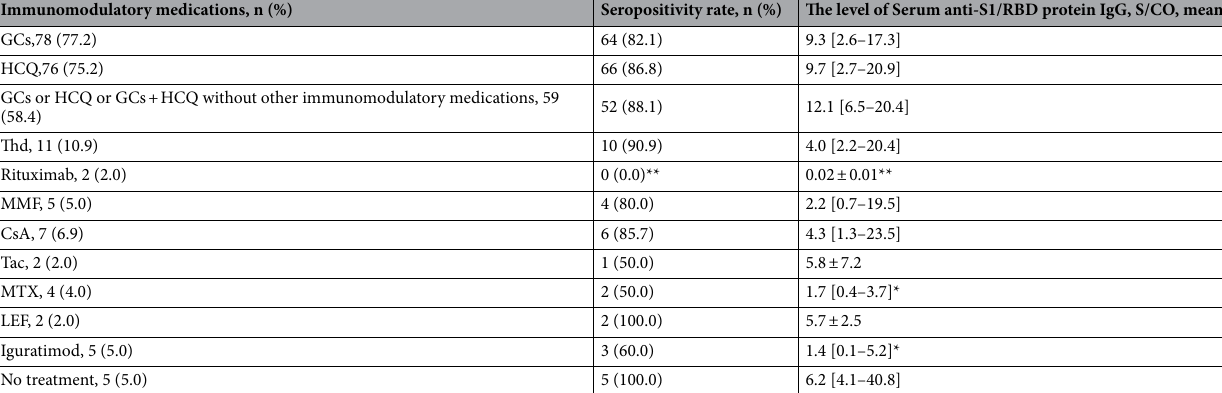
Table 3. Immunogenicity of the inactivated COVID-19 vaccine according to the use of immunomodulatory medications in comparison with controls. GCs glucocorticoids, HCQ hydroxychloroquine, Thd